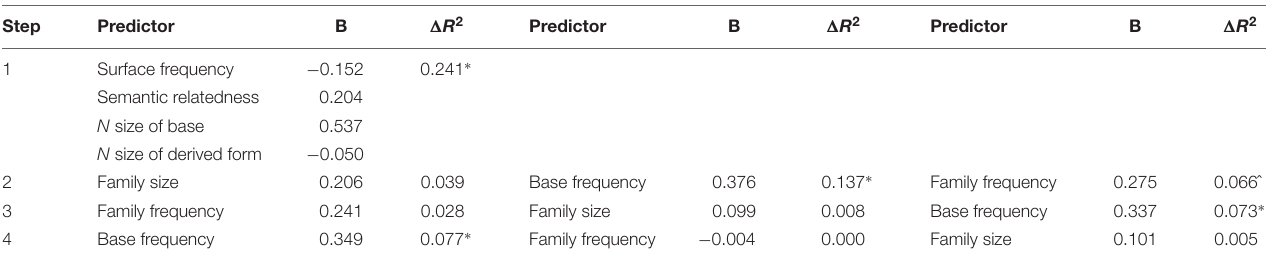
TABLE 2 | Summary of linear regression analyses predicting word accuracy for children in Grades 3 and